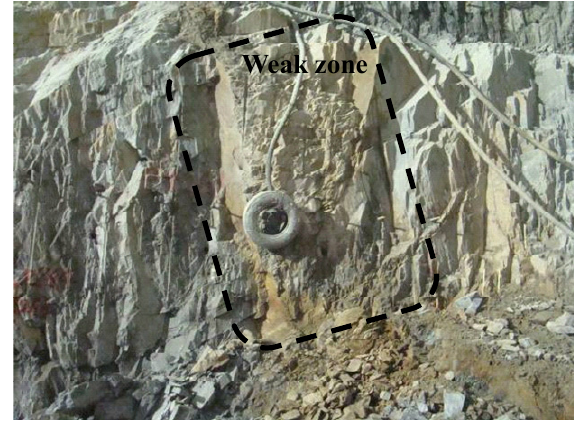
Figure 15. Weak zone of the section R0+263 at the main powerhouse.